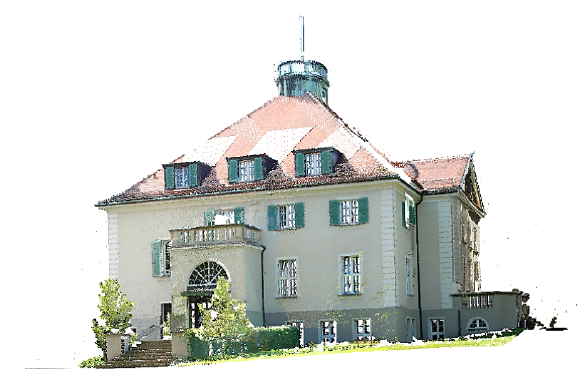
Figure 2: Synthetic image of principalship. Input data: coloured point cloud.